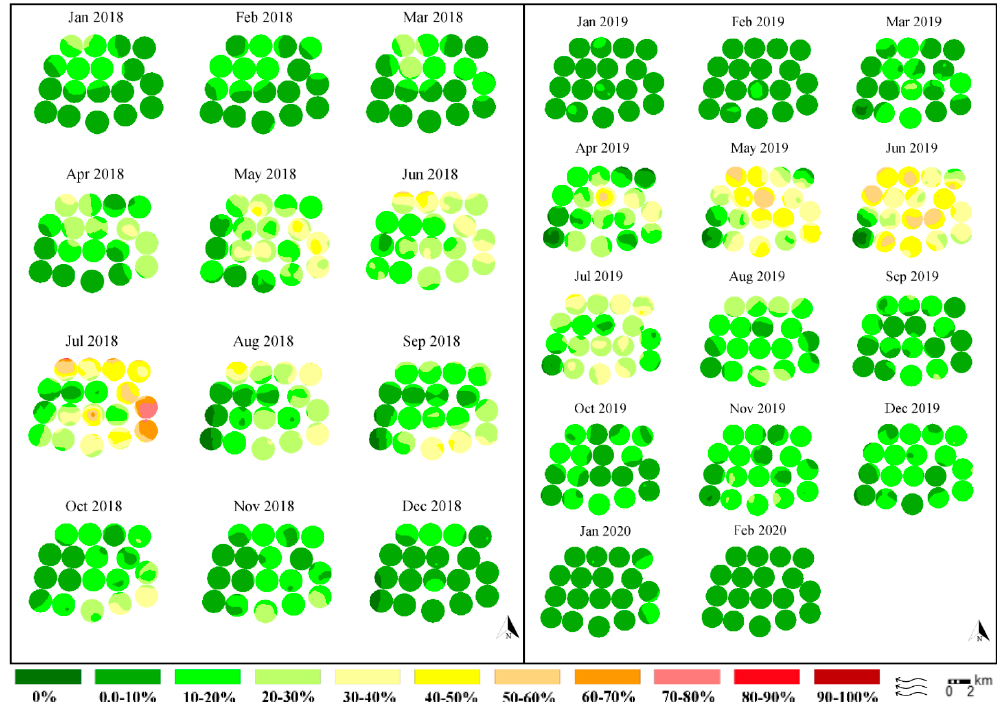
Figure 4. Spatial distribution maps of Leucoptera coffeella in the 18 coffee cultivation pivots of Milan Farm from January to December 2018 (year 3) and from January to December 2019 (year 4) and January and February 2020 (year 5). Each circle on the map represents a 100 ha pivot. The color indicates the percentage (in the bars) of L. coffeella density.